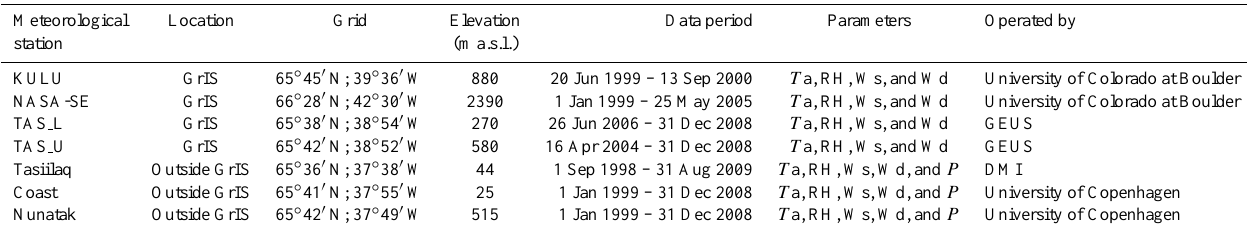
Table 1. Meteorological input data for the Sermilik Fjord simulation based on meteorological station data on the GrIS: KULU and NASA-SE (provided by University of Colorado at Boulder) and TAS L and TAS U (by Geological Survey of Denmark and Greenland (GEUS)), and from the outside the GrIS: Station Tasiilaq (by Danish Meteorological Institute (DMI)) and Station Coast and Station Nunatak (by University of Copenhagen, Department of Geography and Geology). The abbreviations indicate: ( T a) air temperature, (RH) relative humidity, (Ws) wind speed, (Wd) wind direction, and ( P ) precipitation. For station locations see Fig. 1b.